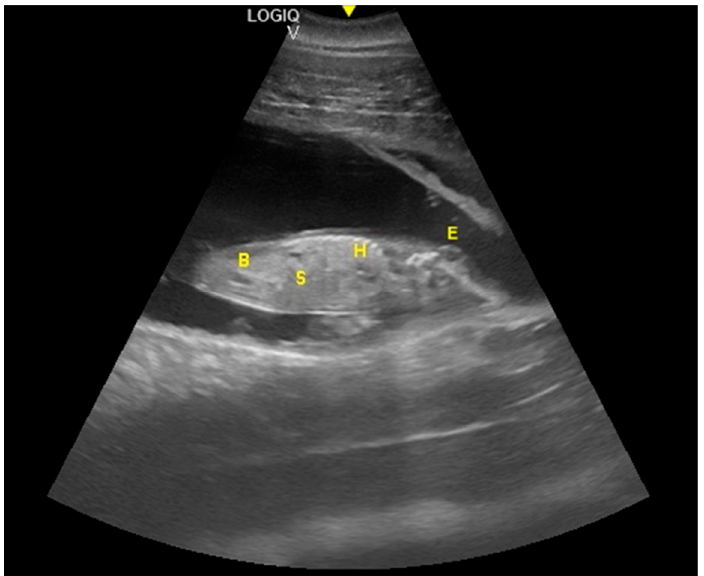
Figure 4. Fetal stomach (S) and fetal urinary bladder (B) were the first abdominal organs to be visualized, and appeared as distinct and anechoic cavities. The heart was recognizable as an anechoic cavity (H) and the embryonic cardiac mechanics were displayed as a point of maximum fluctuation of the echoes. The eye appeared as an anechoic cavitary structure (E).